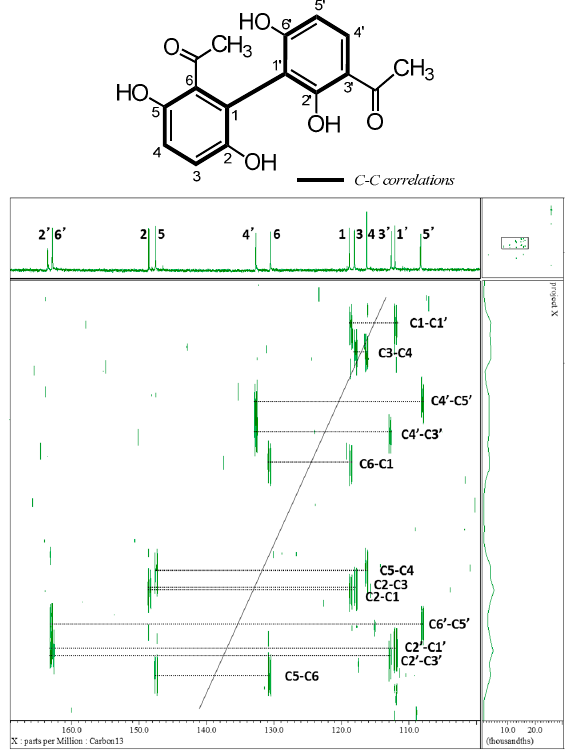
Figure 3. Two-dimensional incredible natural abundance double quantum transfer experiment (2D-INADEQUATE) spectrum of compound 2 .